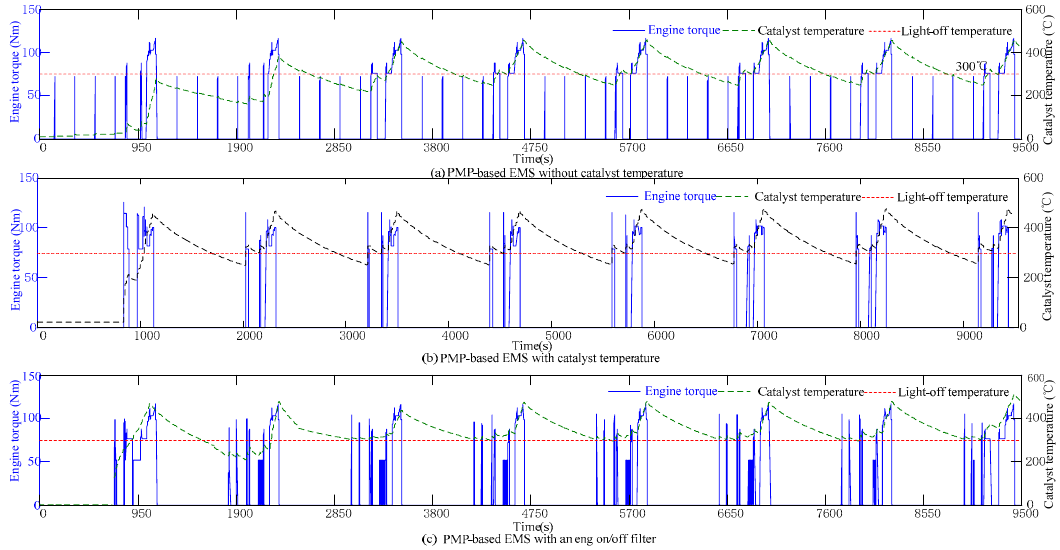
Figure 21. The simulation results under different EMSs for eight repeated NEDC cycles.